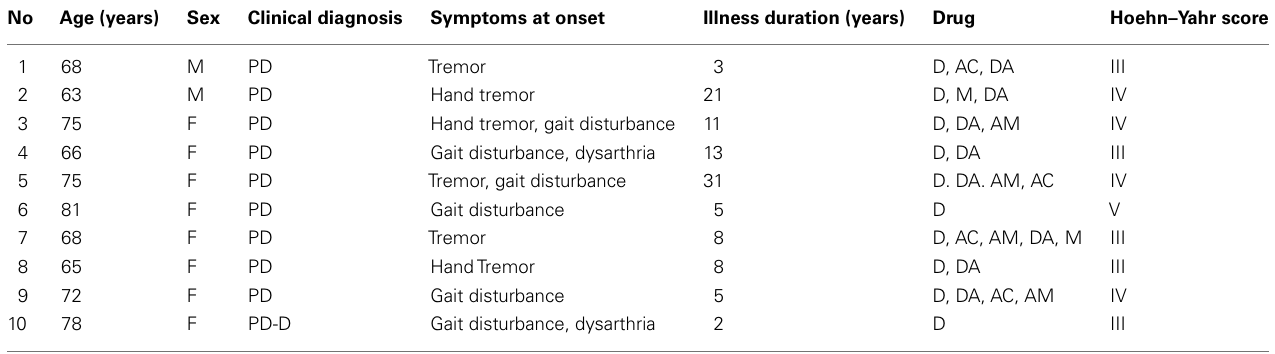
Table 2 | Clinical characteristics of patients with Parkinson